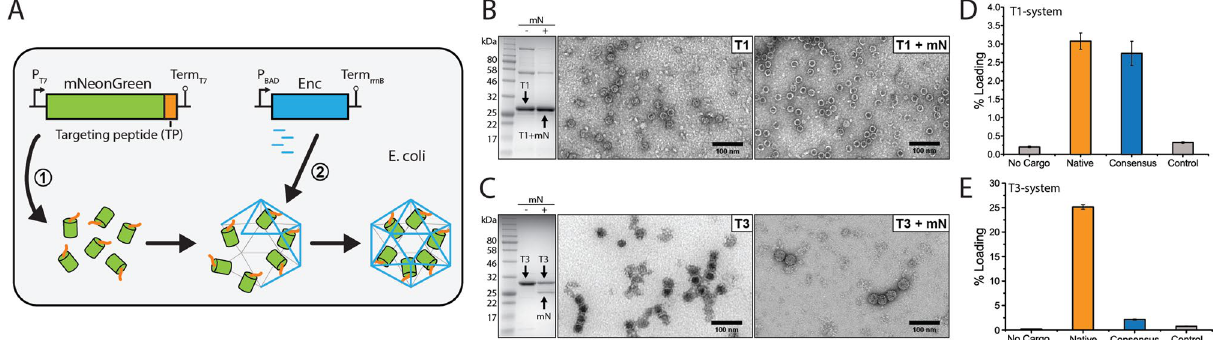
Figure 3. Bulk characterization of encapsulin cargo loading. ( A ) Experimental plan outlining the production and encapsulation of heterologous fluorescent cargo to test targeting peptide strength. ( B ) and ( C ) SDS-PAGE gels and negatively stained transmission electron micrographs of purified encapsulin particles using native TPs. ( D ) and ( E ) Bulk fluorescence measured for the indicated systems and targeting peptides. Error bars represent standard deviations resulting from three independent